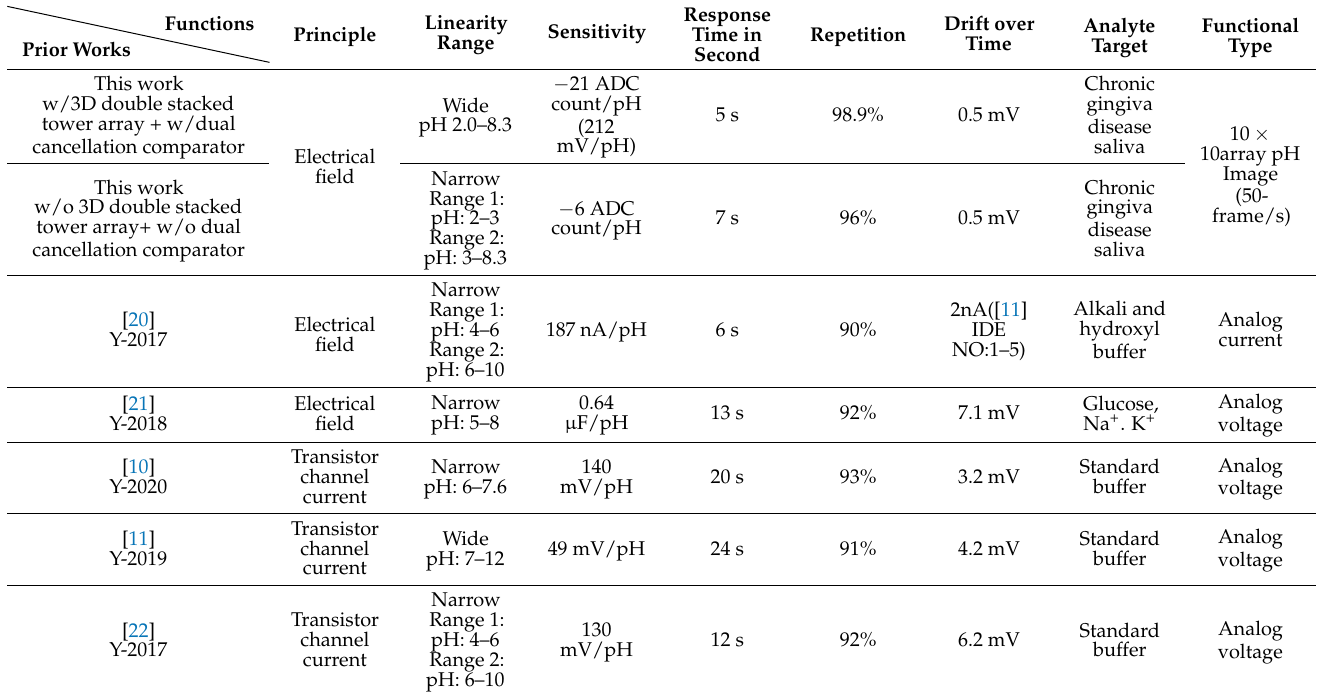
Table 2. Summary of the performance of the proposed double stacked tower sensor array with readout circuit and comparison with prior